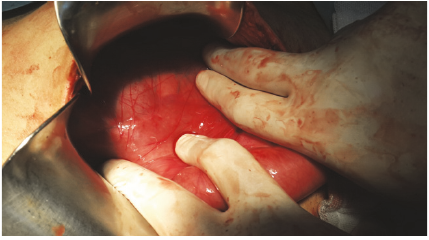
Figure 5: Ischemic small intestine